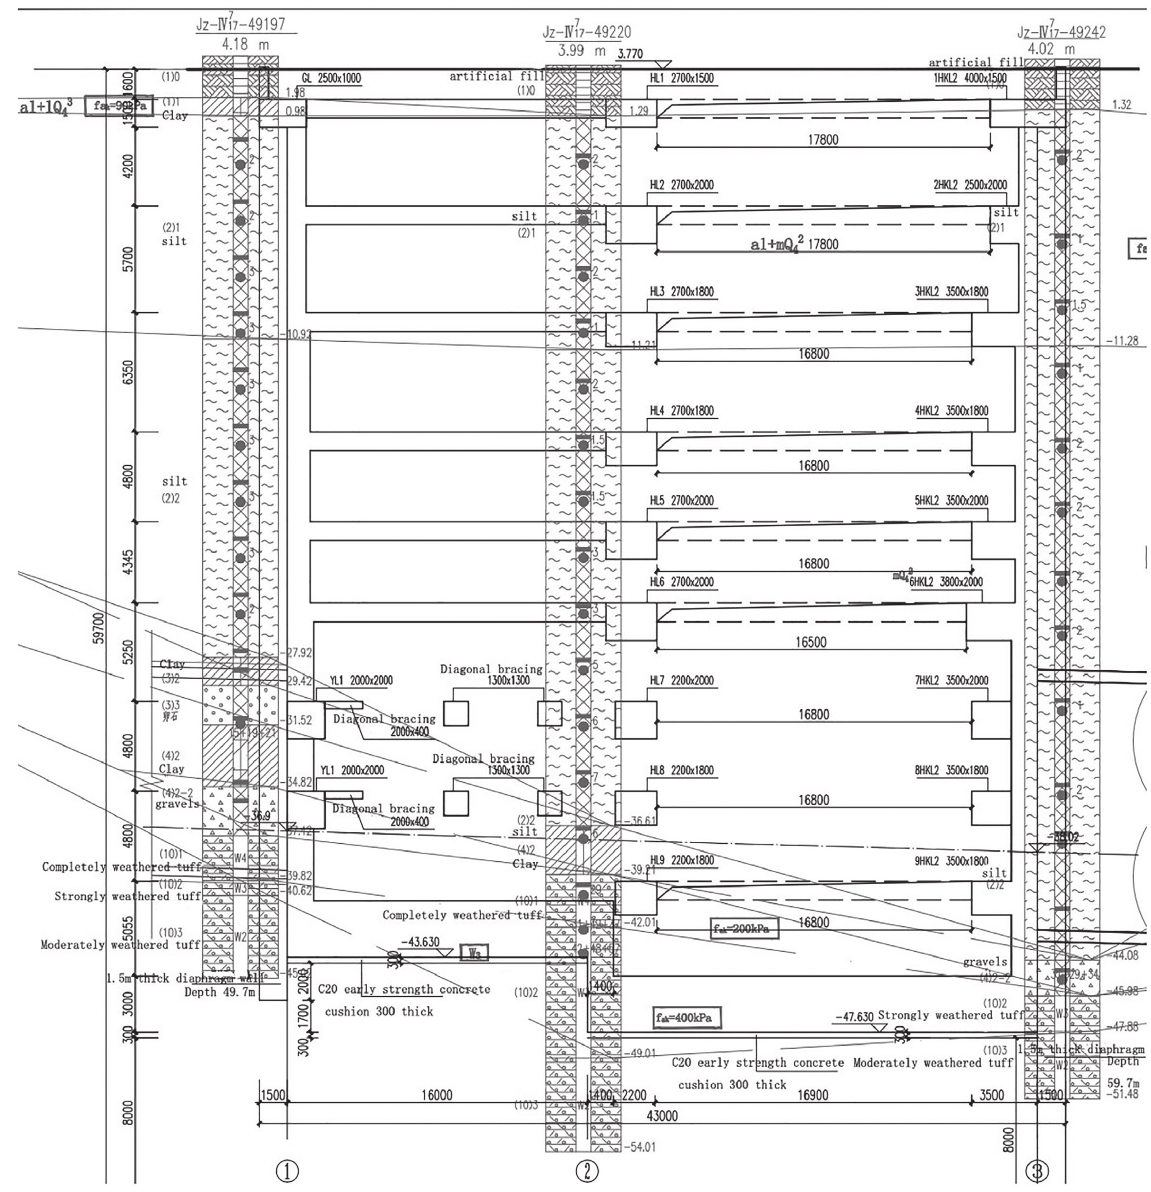
Figure 5: Section diagram of foundation pit supporting Table 1: Material parameters of soil layer.